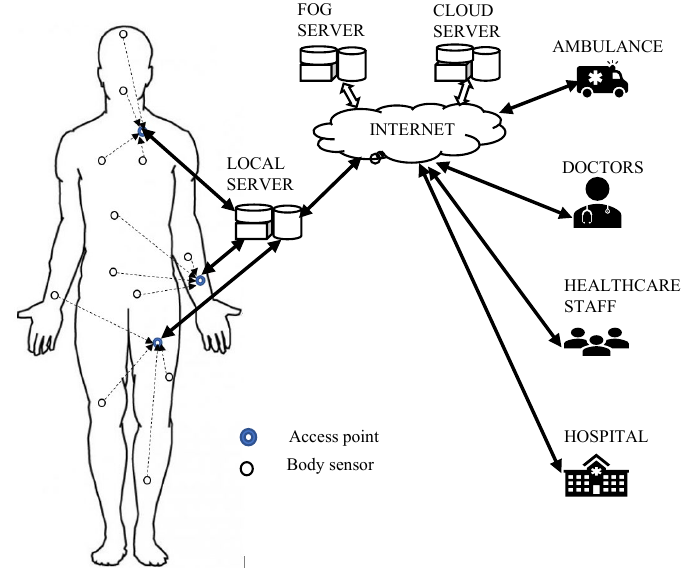
Figure 3. Wireless body area